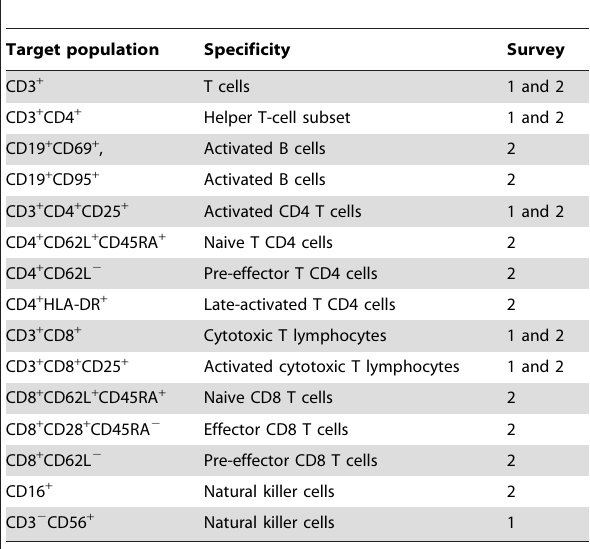
Table 6. Cell lymphocyte populations targeted in surveys 1 and